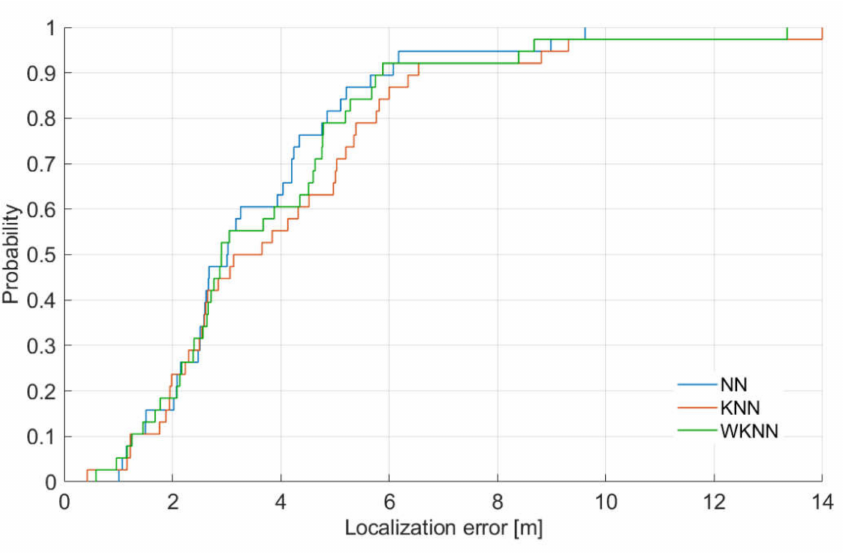
Figure 6. CDF of achieved localization